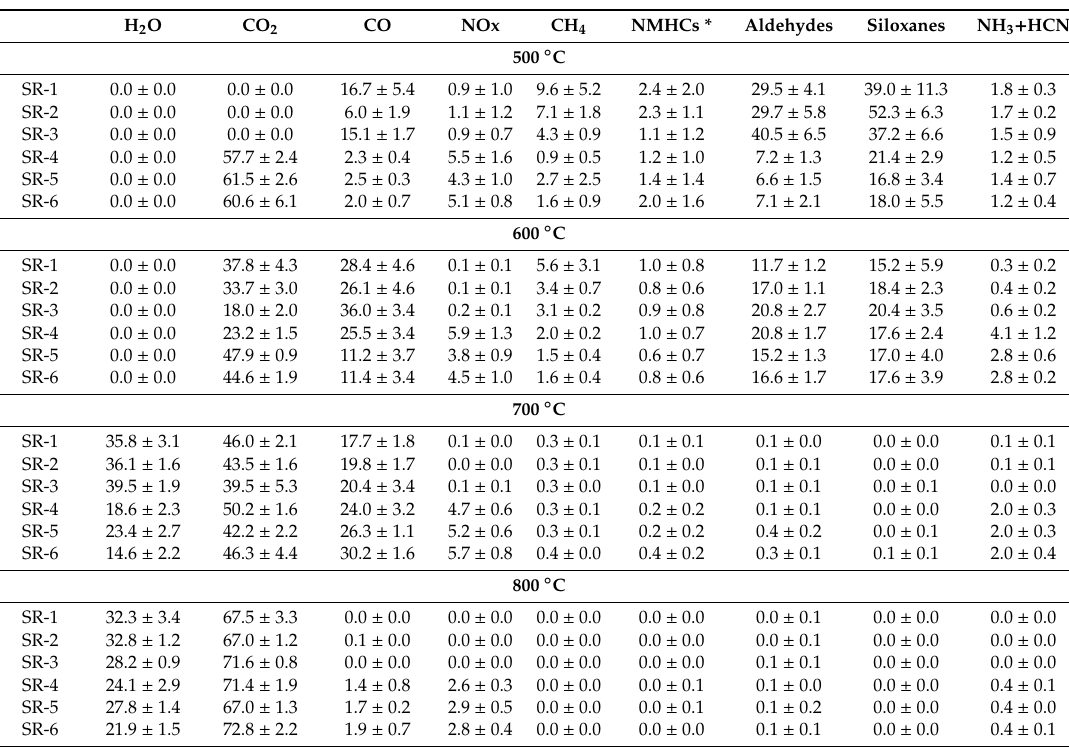
Table 3. Composition of gases emitted from silicone rubber composites combustion, wt.%.